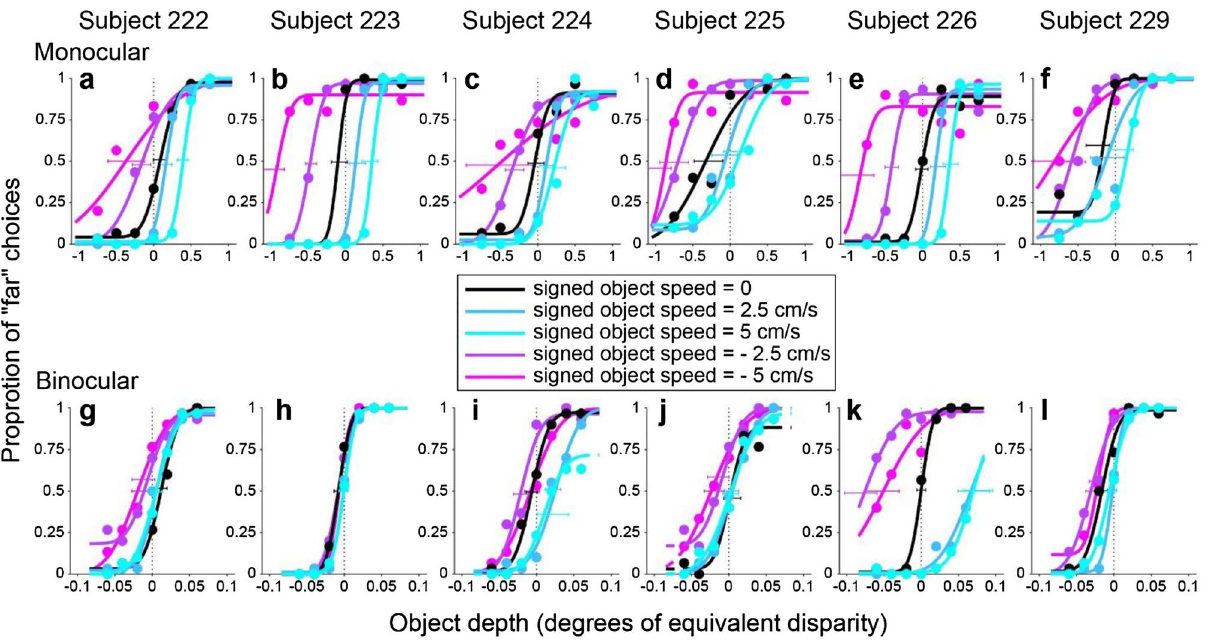
Figure 5. Behavioral results from all six subjects. ( a – f ) Depth psychometric functions for the monocular condition from all six subjects. Note that the left end of the confidence intervals for SOS = − 5 cm/s were cut off by the vertical axis in panels b, d, and e (for visual clarity). ( g – l ) Depth psychometric functions in the binocular condition for the same subjects. Color scheme as in Fig.